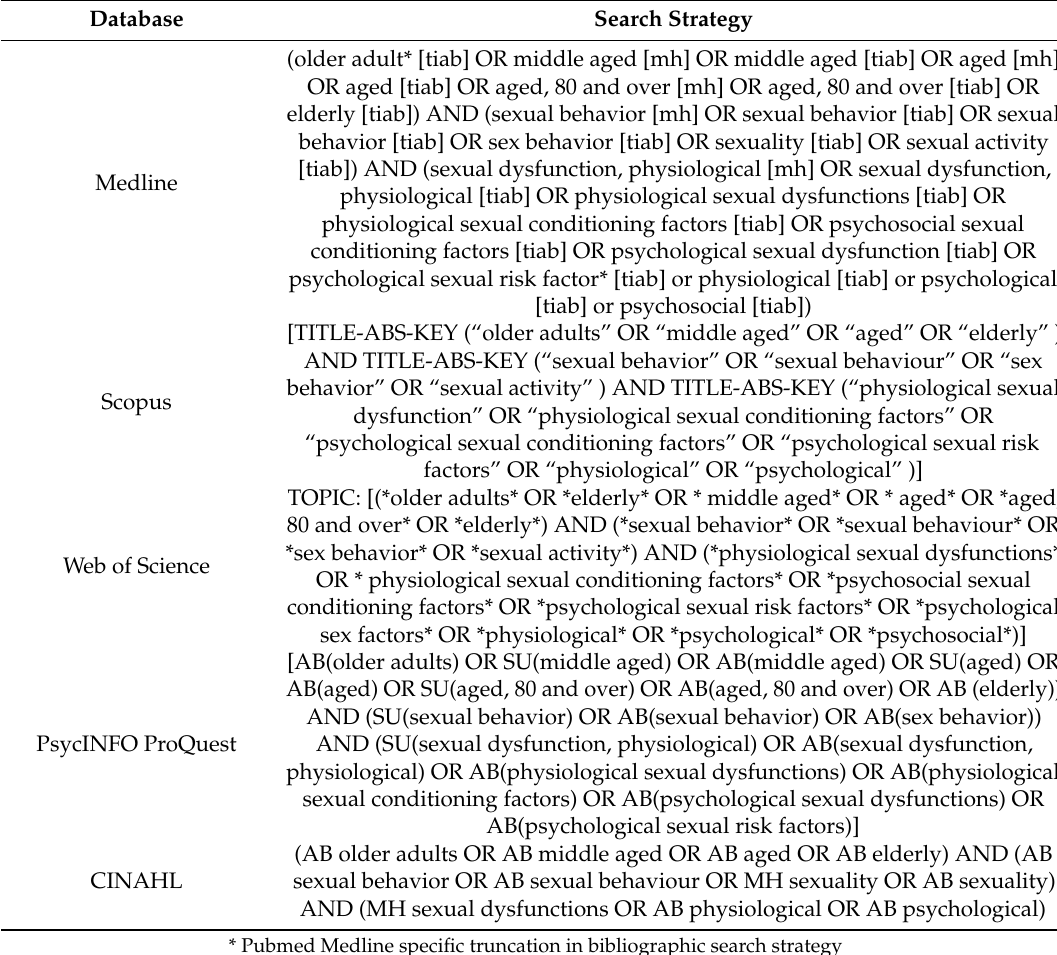
Table 1. Bibliographic search strategy in each database.